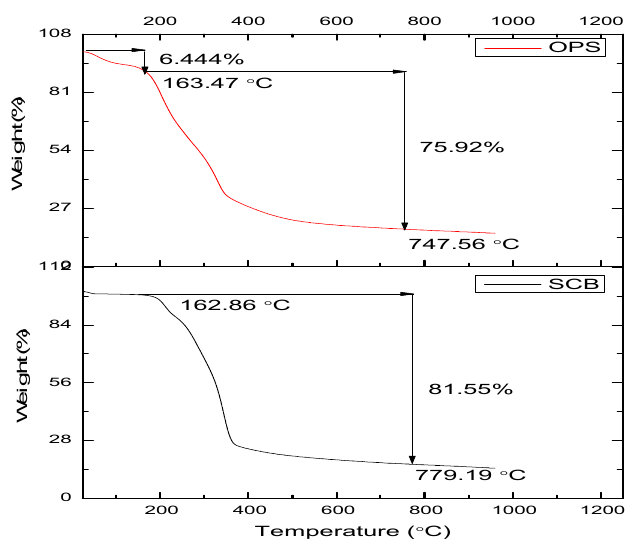
Figure 3. TGA thermograms of SCB and OPS.